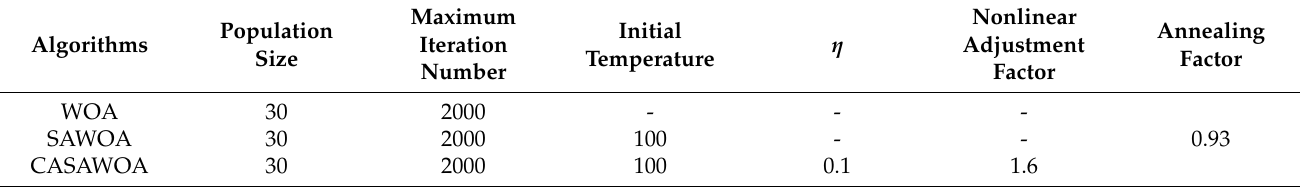
Table 2. Main parameters of WOA-based algorithms.